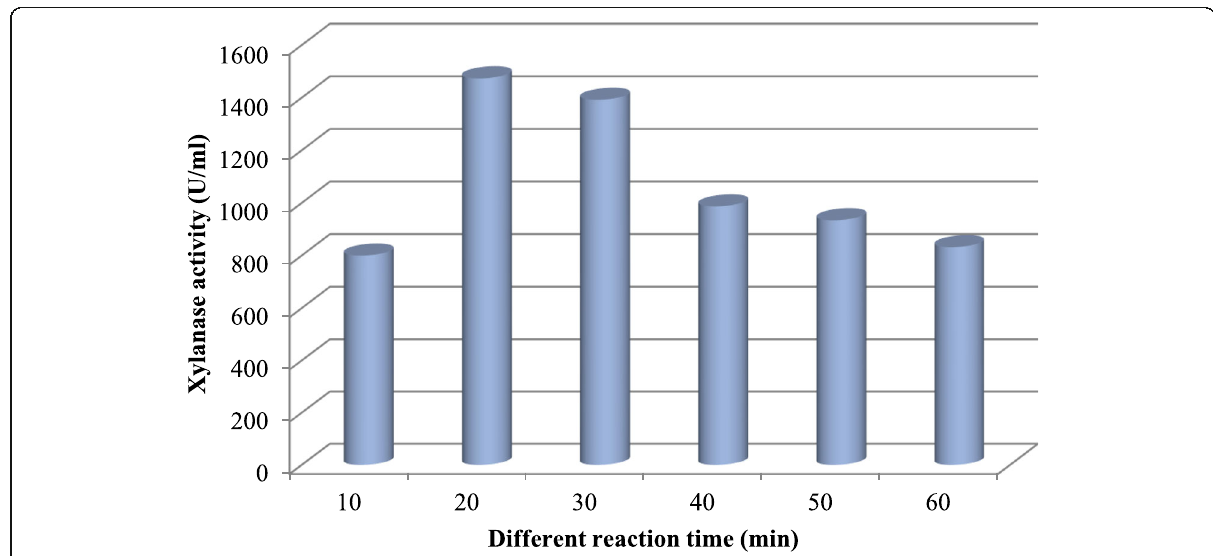
Fig. 6 Effect of different reaction time on crude xylanase